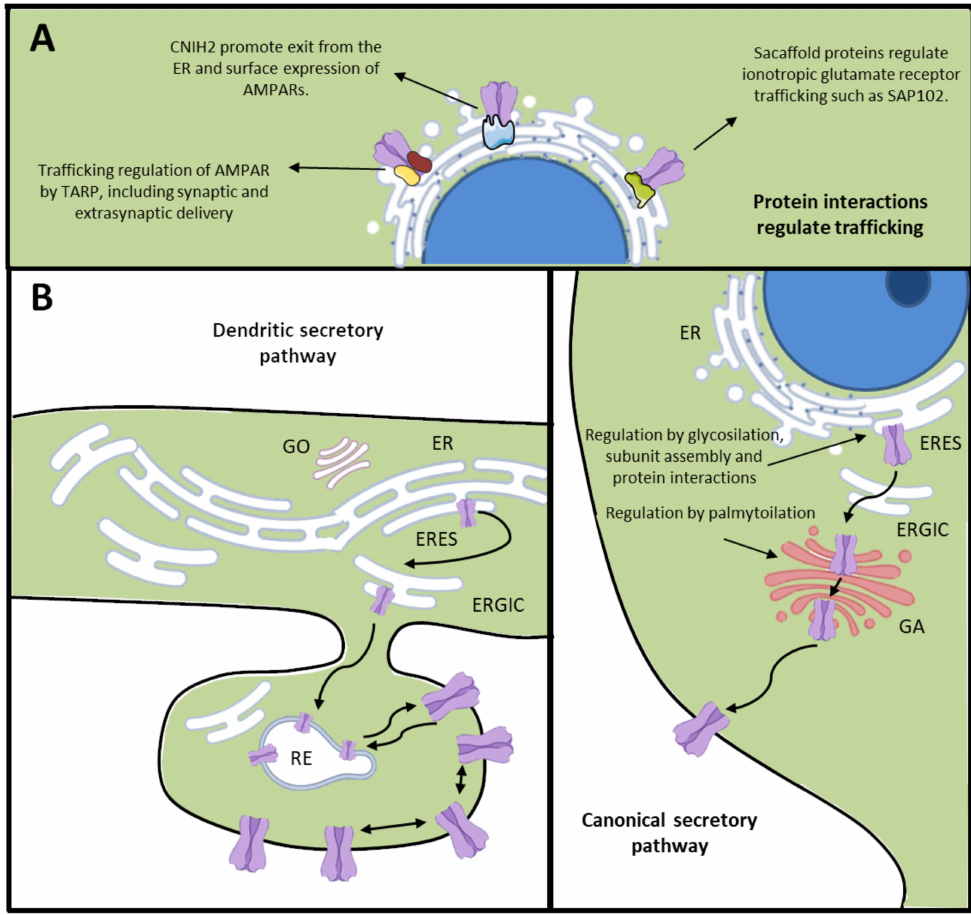
Figure 2. Ionotropic glutamate receptor tra ffi cking. ( A ) Protein interactions regulate exocytic tra ffi cking of ionotropic glutamate receptors, such as TARPs, Cornichon proteins, and sca ff olding proteins, among others. ( B ) (Left) Dendritic secretory pathway, indicating the presence of ER, ERES, ERGIC, and GO in the dendrites. Moreover, it shows the action of recycling endosomes in the anterograde secretory pathway for glutamate receptors to the plasma membrane. (Right) Canonical secretory pathway for glutamatergic receptors in the somatic ER, and tra ffi cking through ERGIC and GA. Neurons use both pathways in neuronal development and plasticity. ER: endoplasmic reticulum, ERES: endoplasmic reticulum exits sites, ERGIC: ER–Golgi intermediate compartment, GO: Golgi outpost, GA: Golgi apparatus, TARP: transmembrane α -amino-3-hydroxy-5-methyl-4-isoxazole propionic acid receptor regulatory